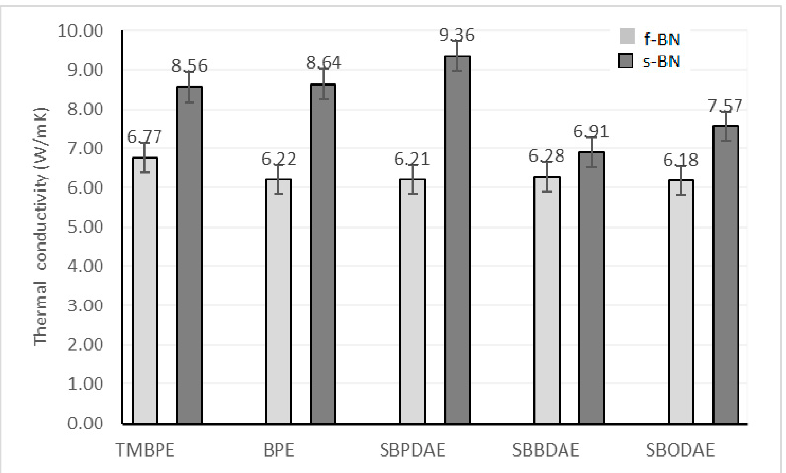
Figure 6. The thermal conductivity of flat boron nitride (f-BN) and spherical boron nitride (s-BN) composites.